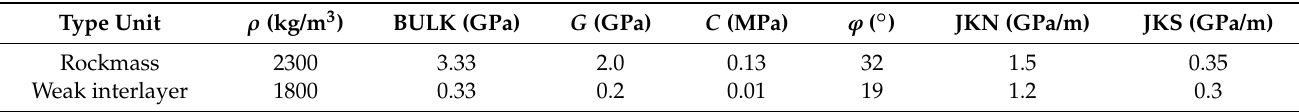
Table 2. Mechanical parameters of rockmass and weak interlayer.